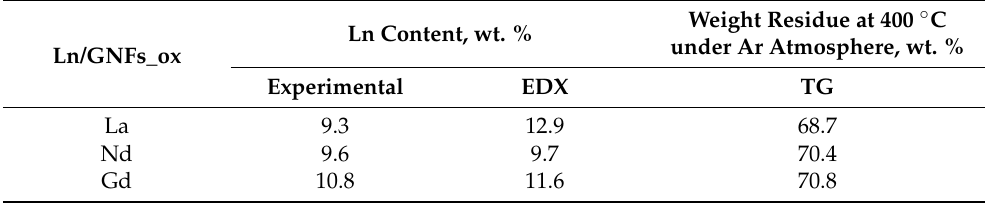
Table 1. The weight content of Ln in the Ln/CNFs_ox samples. Weight Residue at 400 ◦ C Ln Content, wt. % Ln/GNFs_ox